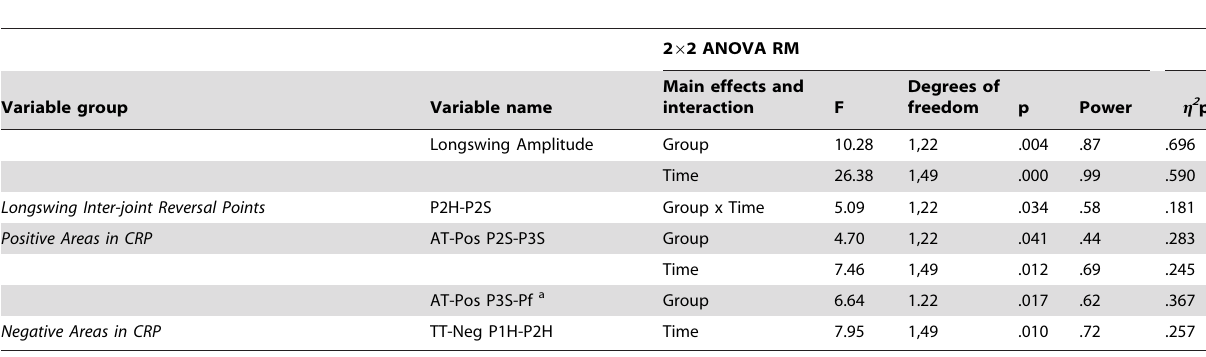
Table 1. Significant results of two (Group) x two (Time) ANOVA with repeated measures (RM).